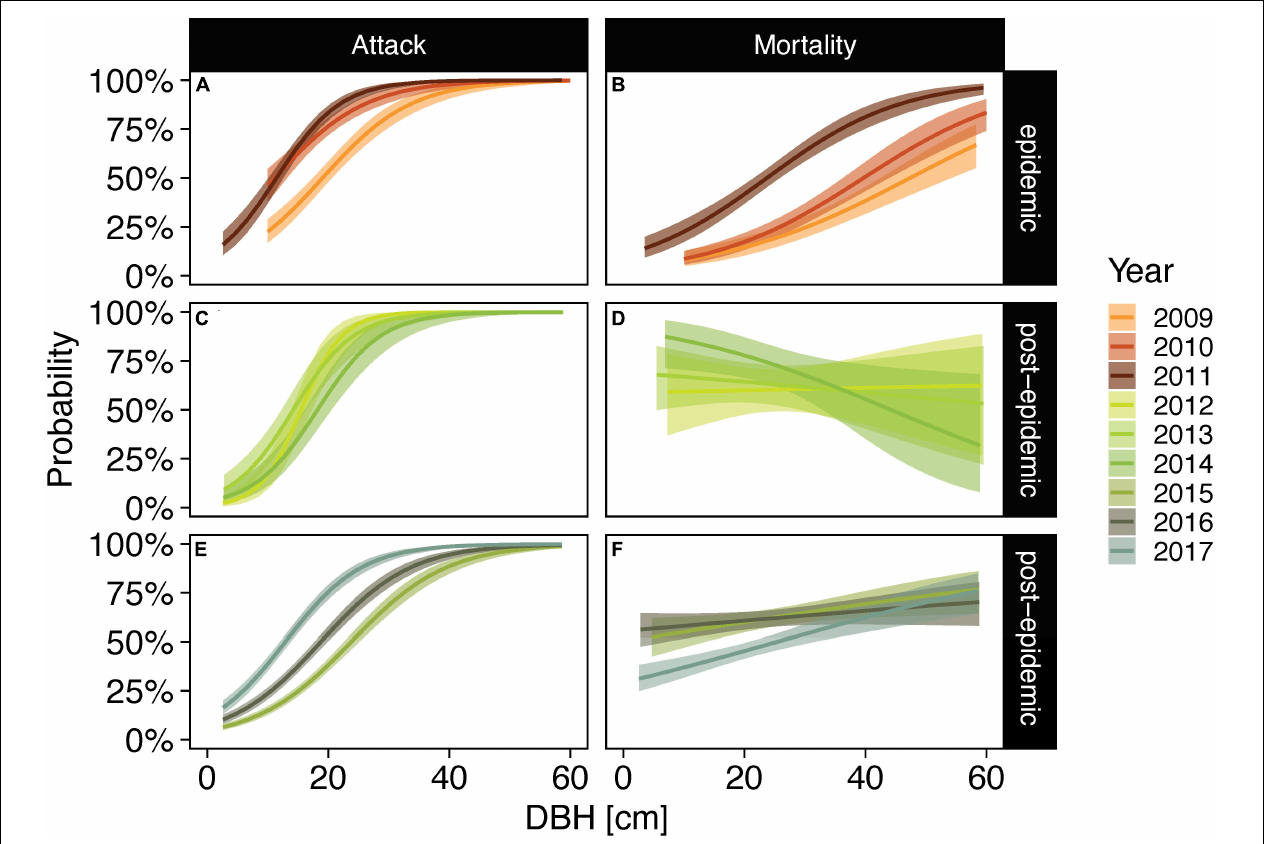
FIGURE 6 | Posterior probabilities of Engelmann spruce trees exhibiting signs of bark beetle attack (A,C,E) and bark beetle caused mortality following infestation (B,D,F) in epidemic years [2008–2011; (A,B) ] and post-epidemic years [2012–2017; (C–F) ] as a function of diameter at breast height (DBH). Post-epidemic years were separated into individual panels showing three years each (2012–2014 and 2015–2017) for easier interpretation of data. Lines represent posterior medians and bands represent the 94% credible